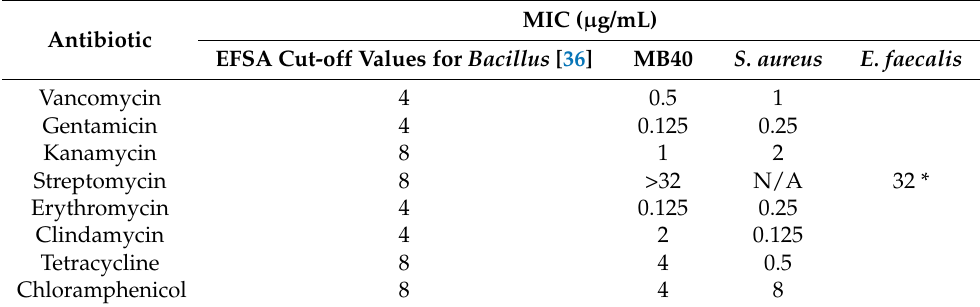
Table 2. Minimum Inhibitory Concentration of Antibiotics for B. subtilis